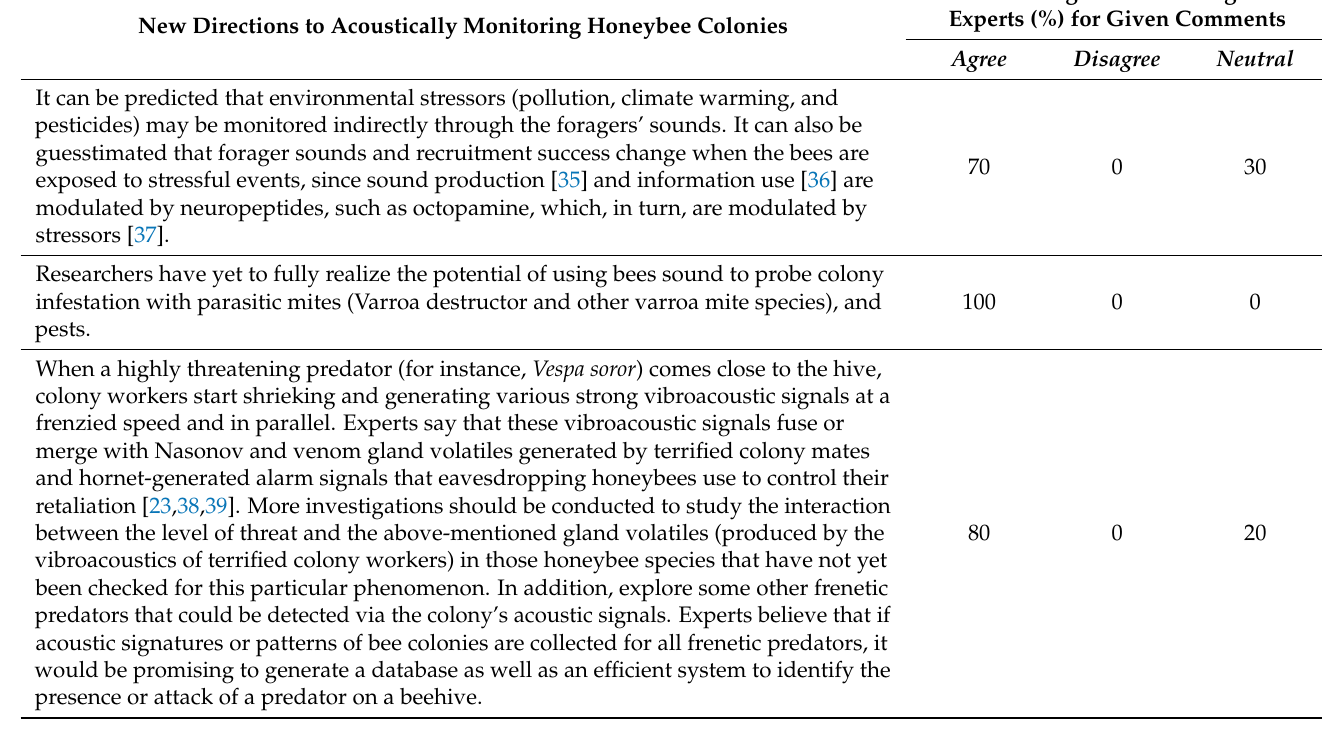
Table 5. A compilation of the experts’ feedback on a question asked in a questionnaire: “What do you suggest are the new areas where honeybee colony acoustics could be used to monitor them?” during the second round of the peer review